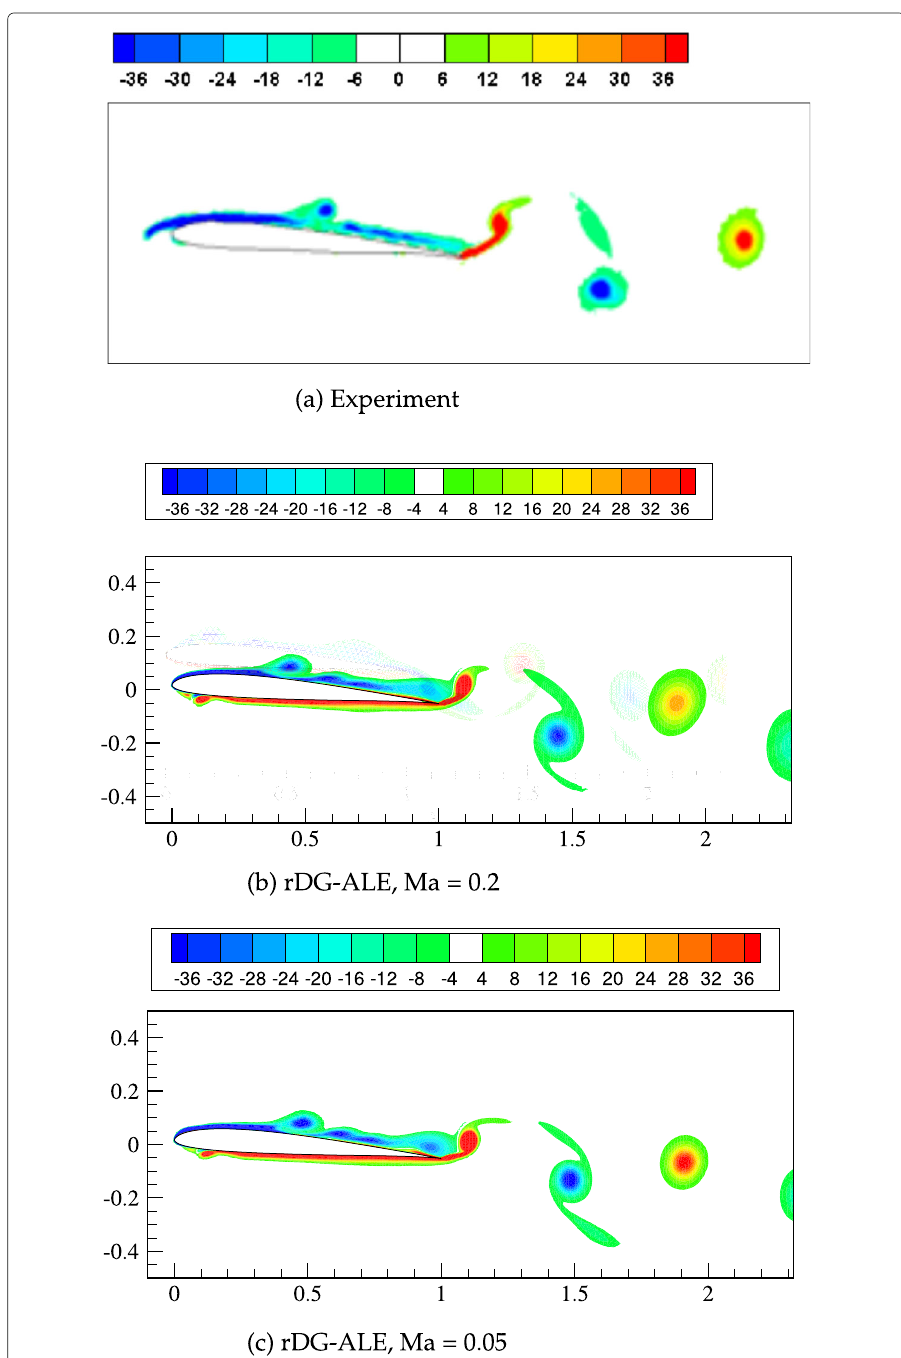
Fig. 19 Comparison of normalized vorticities with experiment at